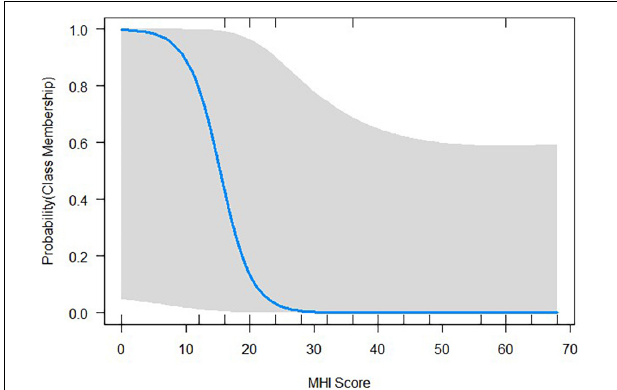
FIGURE 6 | Probability plots illustrating how the class membership probabilities change with the given value of the Mental Health Index (MHI), a subscale of the SF-36 health